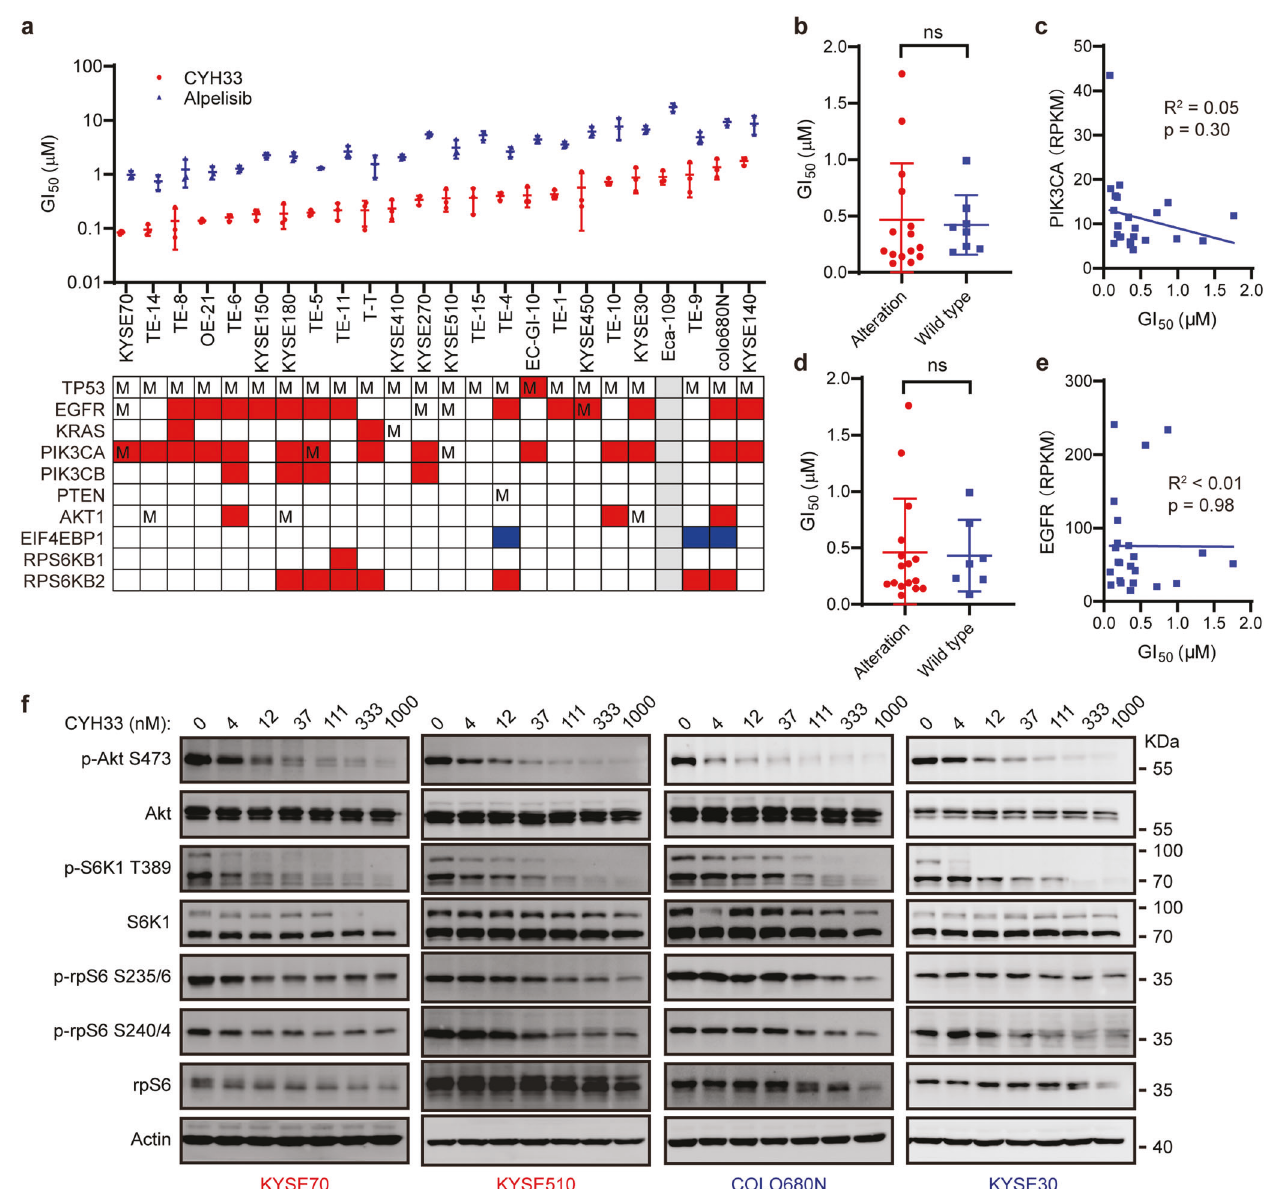
Fig. 1 CYH33 displayed potent while variable anti-proliferative activity in ESCC cells. a The half maximal growth inhibitory concentration (GI 50 ) values of CYH33 and alpelisib against the proliferation of 24 lines of ESCC cells. Data were presented as mean ± SD ( n = 3). Boxes below the chart indicated the genetic alterations in ESCC cells (M, mutation; Red, ampli fi cation; Blue, copy number loss; Grey, no data). Genetic alterations were obtained from CCLE database (https://sites.broadinstitute.org/ccle/). b , d Scatter plots of mean GI 50 values of CYH33 in cells grouped by alterations in PIK3CA ( b ) and EGFR ( d ). Difference between groups was analyzed by two-tailed unpaired Student ’ s t -test. ns, p > 0.05. c , e Pearson correlation analysis of the mean GI 50 values of CYH33 and RPKM values of PIK3CA ( c ) or EGFR ( e ) was presented. RPKM values of PIK3CA and EGFR were obtained from CCLE database. f ESCC cells were treated with indicated concentrations of CYH33 for 1 h. Cell lysates were then subjected to Western blot for the indicated those in resistant cells, suggesting intact regulation at G1 phase (CDKs) including CDK4 and CDK6 and executes its oncogenic in CYH33-sensitive cells. We evaluated the anti-proliferative effect by promoting unlimited cell cycle progression. 27 We thus activity of palbociclib, the fi rst approved CDK4/6 inhibitor for selected three sensitive ESCC cell lines with CCND1 copy number the treatment of patients with HR-positve, HER2-negative breast >2 and three resistant ESCC cell lines with CCND1 copy number cancer, in these 6 lines of ESCC cells. Palbociclib was signi fi cantly <2 to interrogate cell cycle pathway focusing on G1 phase more potent against the proliferation of CYH33-sensitive cells regulation. As shown in Fig. 3a and Supplementary Fig. S4b, no with an average inhibitory rate of 37.1% than that of the resistant signi fi cant difference in the level of phosphorylated Akt was cells (inhibitory rate of 5.8% at the same concentration) (Fig. 3b). found in sensitive cells (KYSE410, TE-8, and TE-11) and resistant This observation indicated that CYH33-sensitive cells were more cells (KYSE450, Eca109, and TE-1), while elevated expression of vulnerable to the blockade of G1/S transition. To determine proteins in charge of G1/S transition, including cyclin D1, p21, and whether CYH33 exerts its anti-proliferative activity by disturbing phosphorylated Rb was observed in sensitive cells compared to